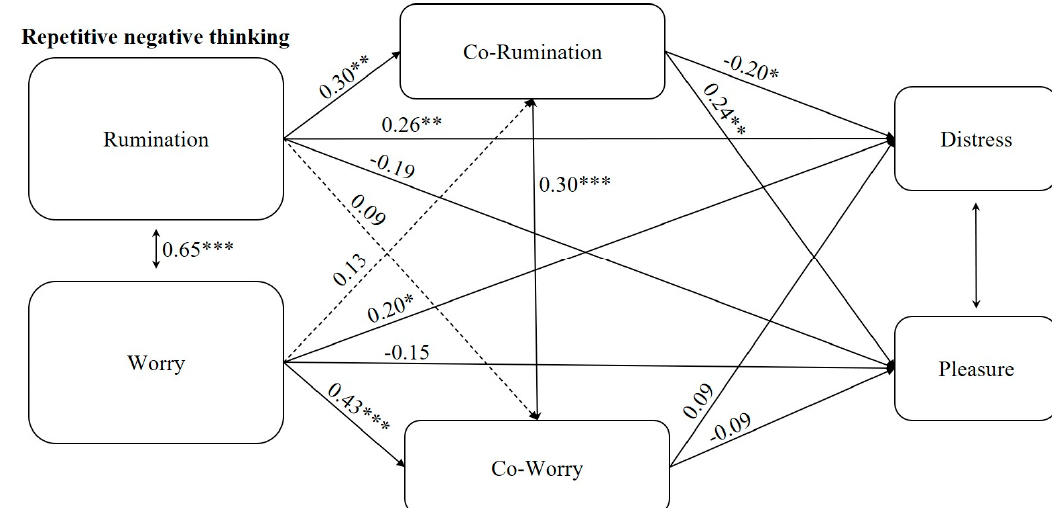
Figure 2. Results of the association of repetitive negative thinking with sexual distress and sexual pleasure. Note: The model is saturated, with no adjustment index. Only the indirect effect for pleasure through co-rumination is significant: Rumination > Co-rumination > Pleasure (Estimate = 0.07; SE = 0.03; p = 0.029). *** p < 0.001. ** p < 0.01. * p < 0.05. The estimates are positioned above the line they refer to.